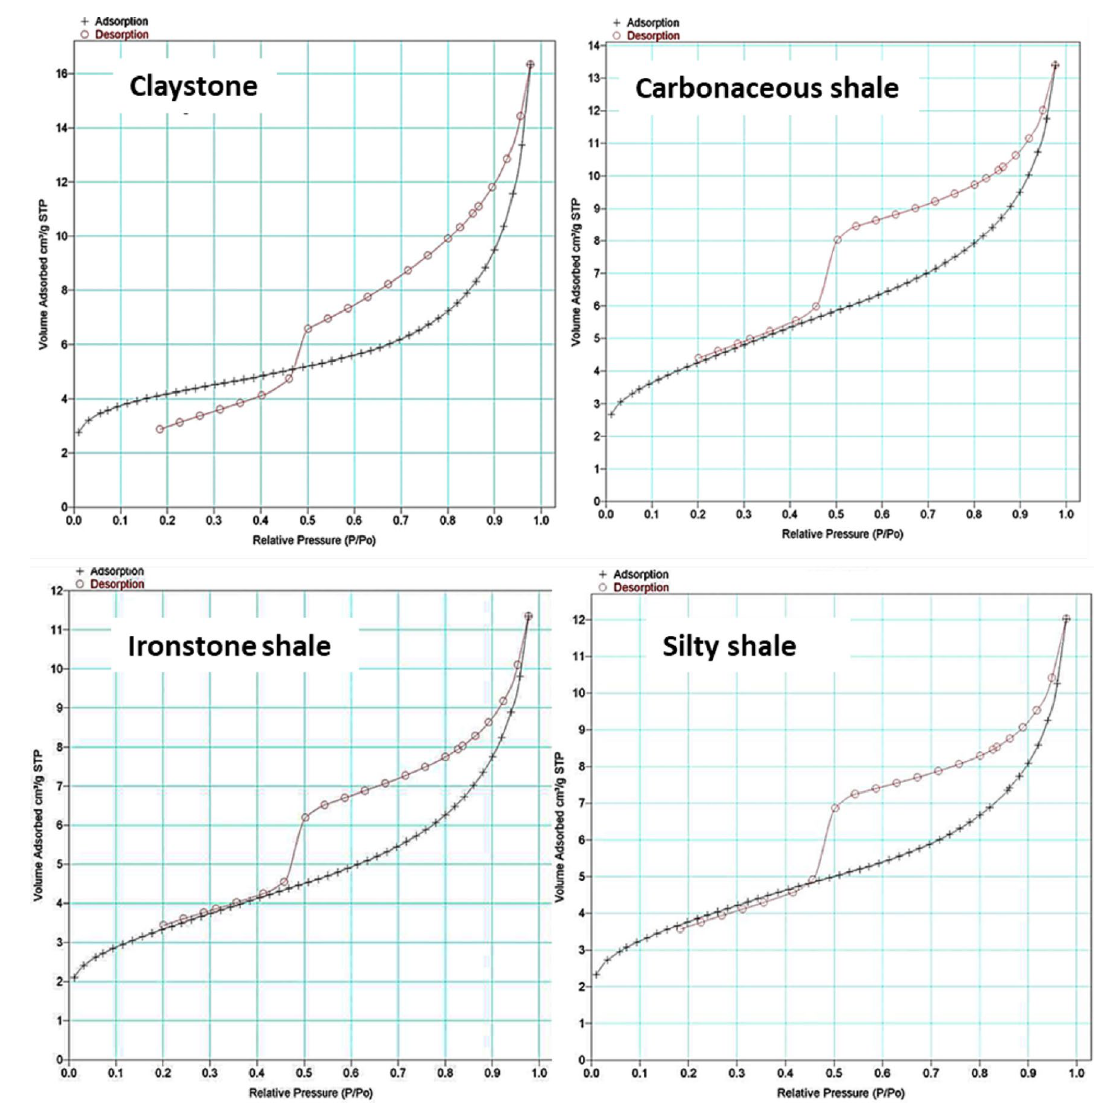
Fig. 6 N 2 adsorption isotherms at 77 K of a representative shale samples. B. Figure is showing the isotherm ‘forced closure’ in the relative pres- sure ( P / P 0 ) range 0.48–0.50 due to tensile strength effect